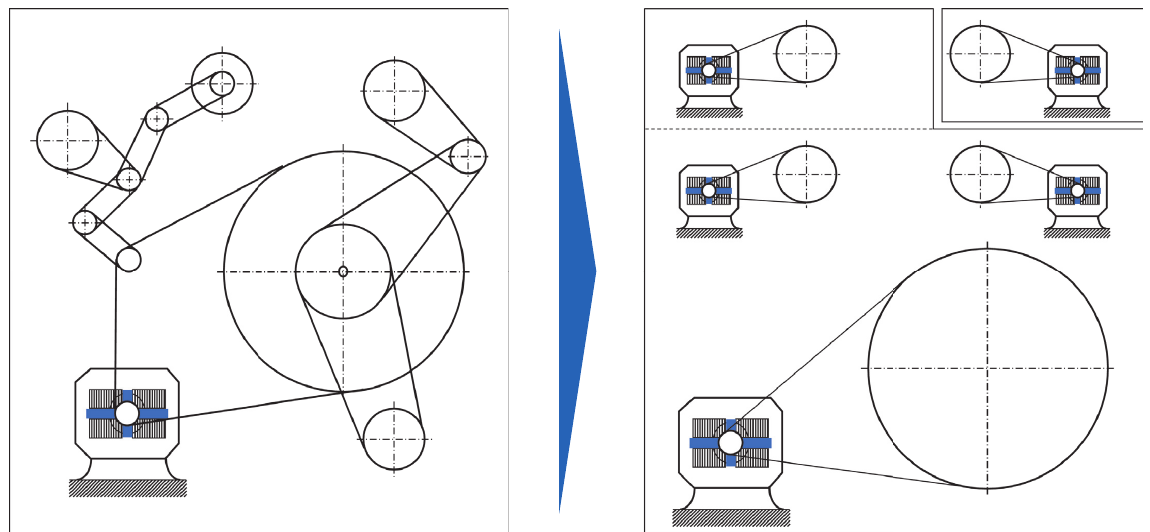
Figure 6: Two parts as KiBaM treats the battery.